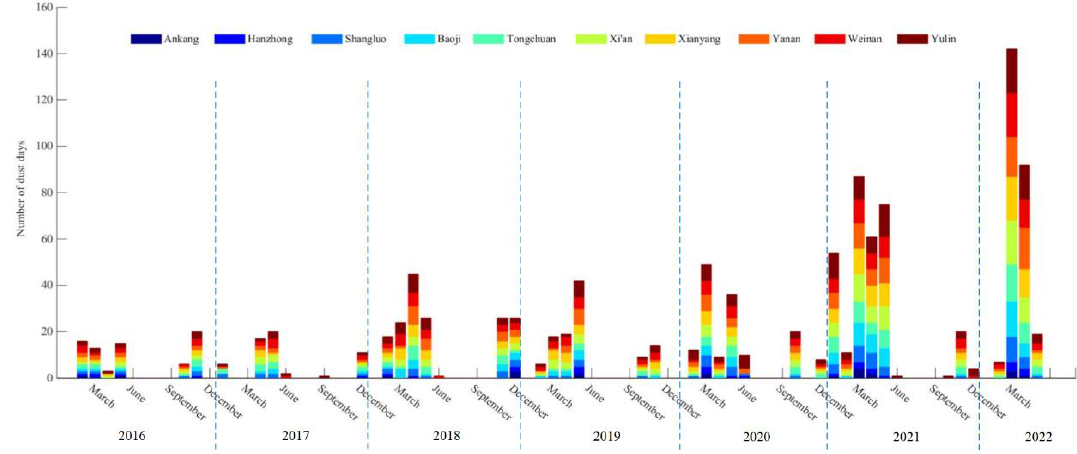
Figure 8. Frequency and distribution of dust weather from 2016 to 2022.